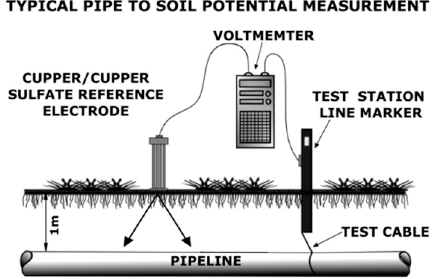
Figure 9. Typical procedure for structure-to-soil potential survey [97].